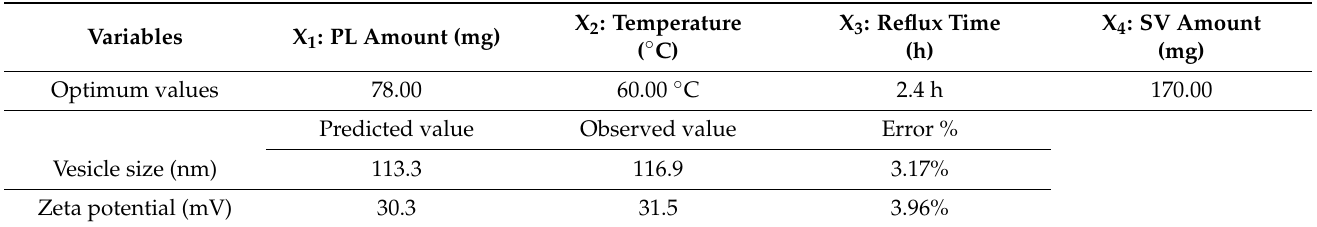
Table 4. Optimized independent variable levels and the c predicted and observed responses of the optimized QRT-PHM-SV formulation.